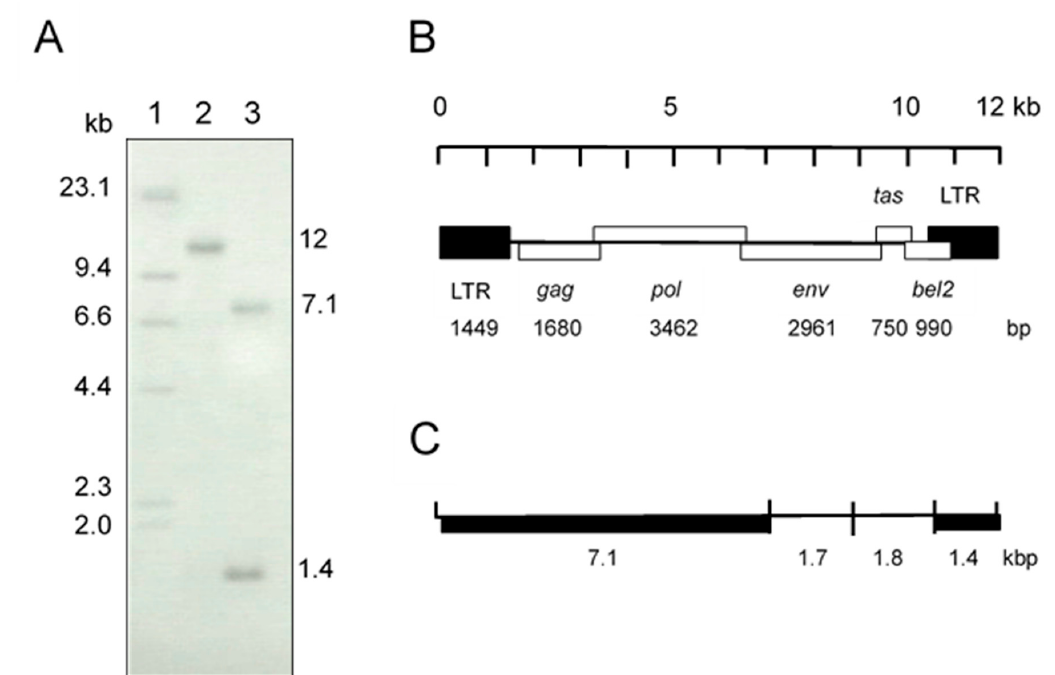
Figure 2. ( A ) Southern blot analysis of total DNA from HFK cells infected with the isolate. The LTR region was used as a probe. Lane 1: molecular weight marker, lambda DNA Hin dIII digest labeled